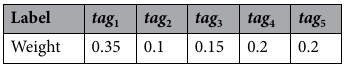
Table 8. Label weights selected by shipowners.